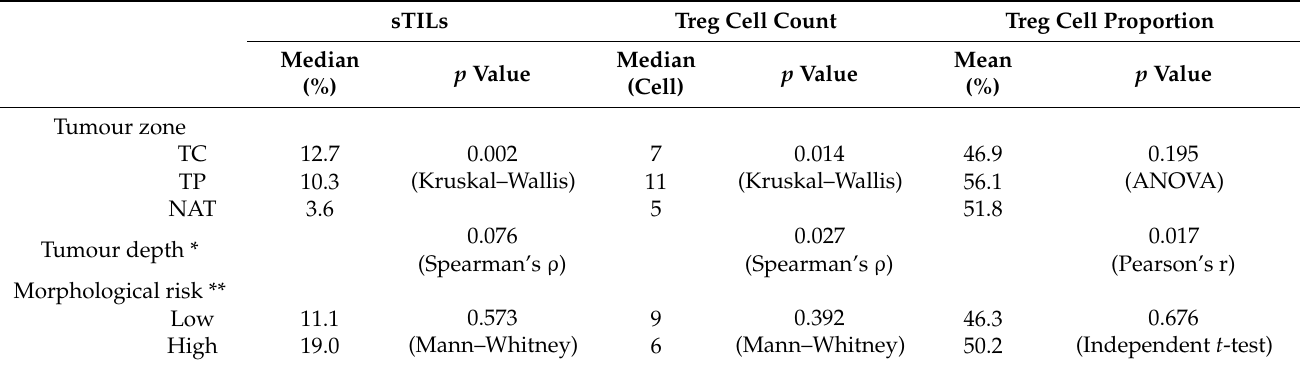
Table 1. Summary of the associations between observed